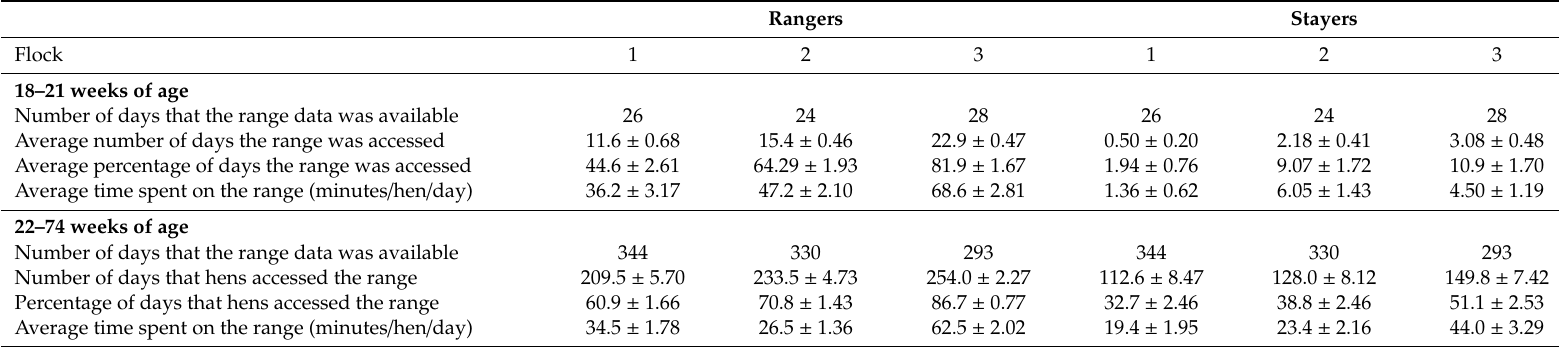
Table 1. Range use (mean ± SEM) of hens ( n = 769) obtained from 3 flocks that were categorized and housed according to their range use during early (18–21 weeks of age) and whole (22–74 weeks of age) ranging life.